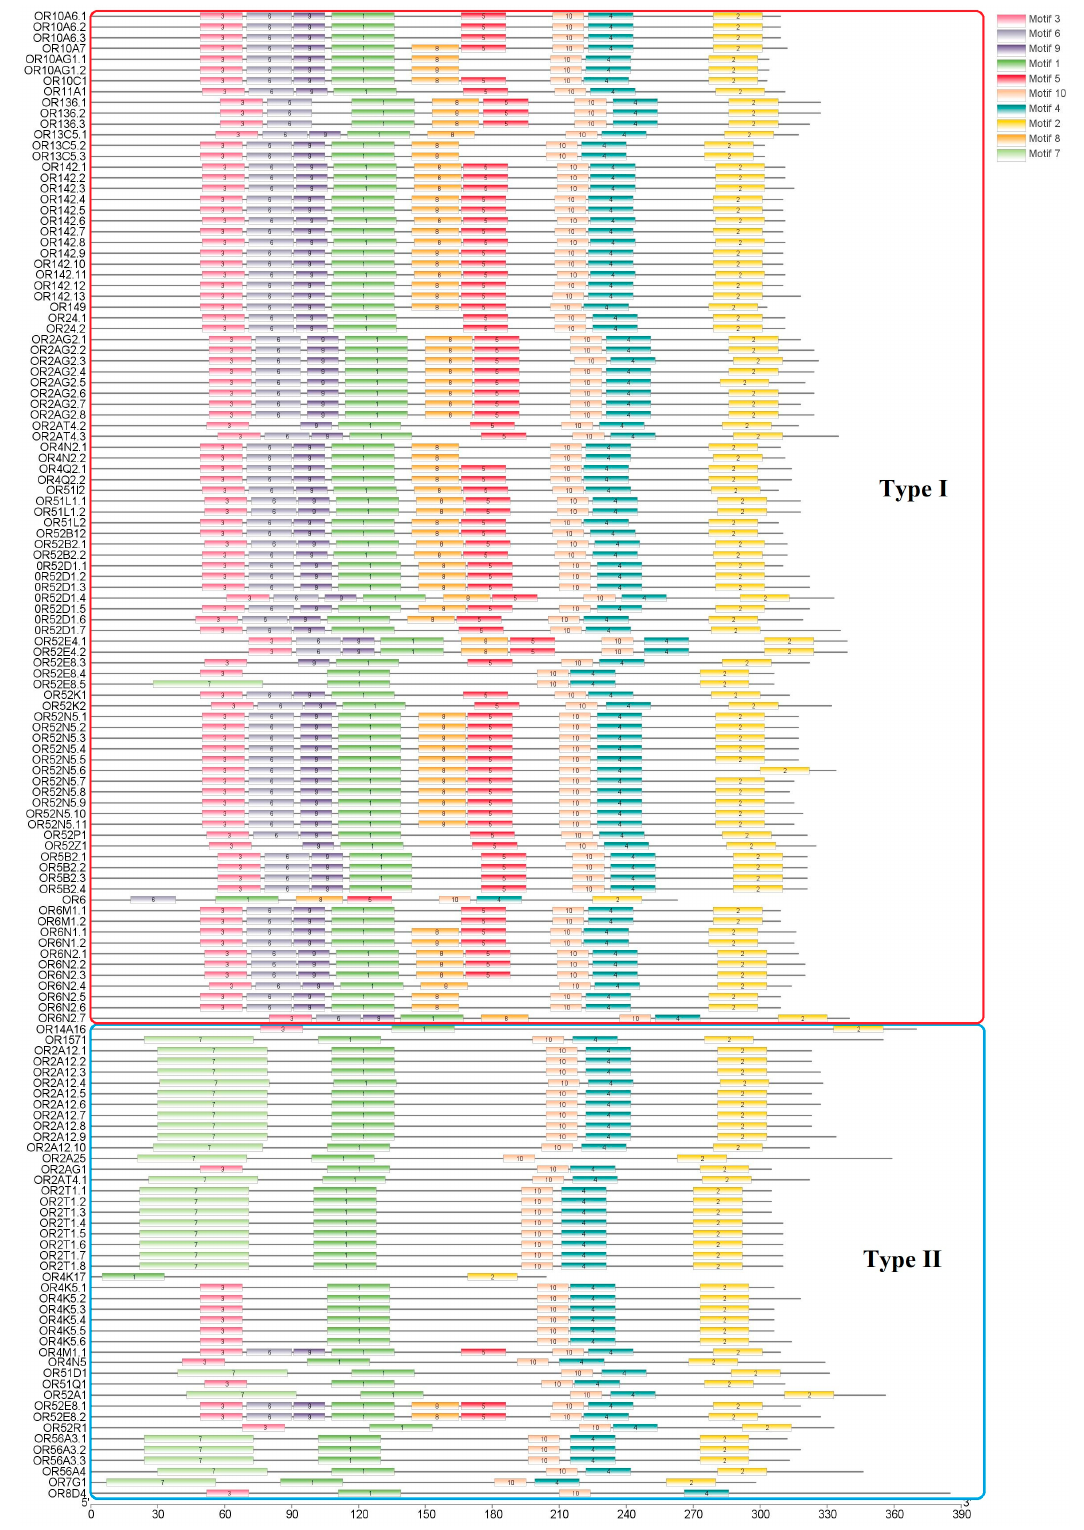
Figure 2. Conserved motifs of OR genes in S. sihama . Different colors differentiate 10 different motifs. The order of the motifs was 7, 3, 6, 9, 1, 8, 5, 10, 4, and 2. The horizontal axis shows the number of amino acids from the N-terminal to the C-terminal. The OR gene conserved motifs in the red border region belong to type I, while those in the blue border region belong to type II.